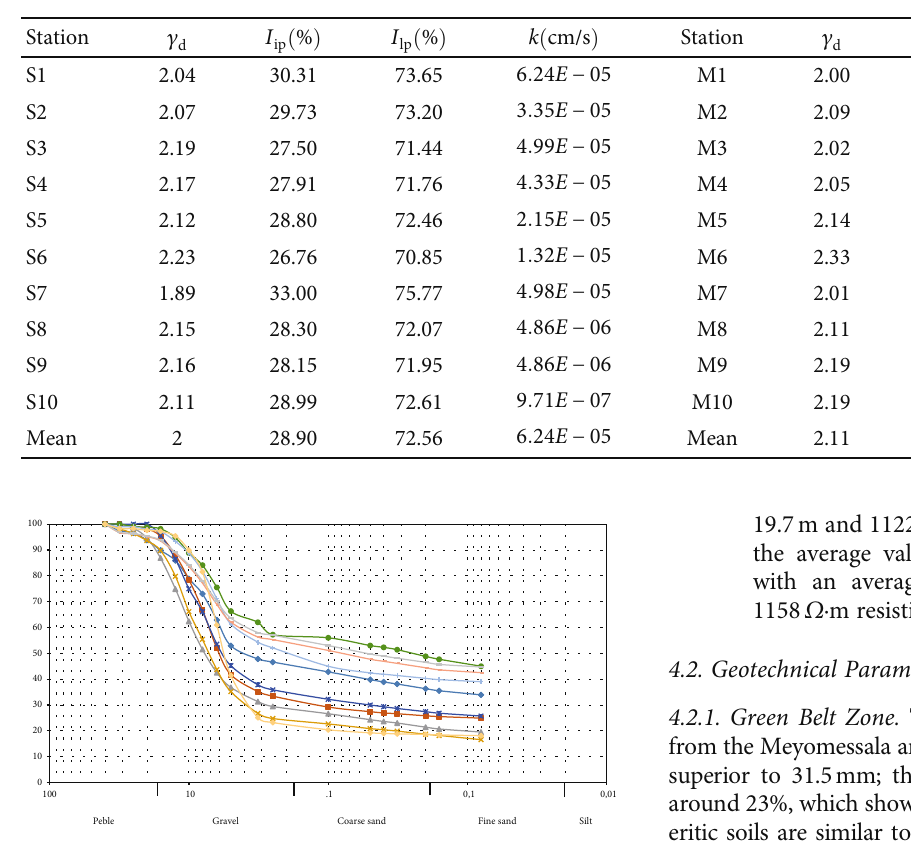
Table 5: Physical and mechanical parameters.